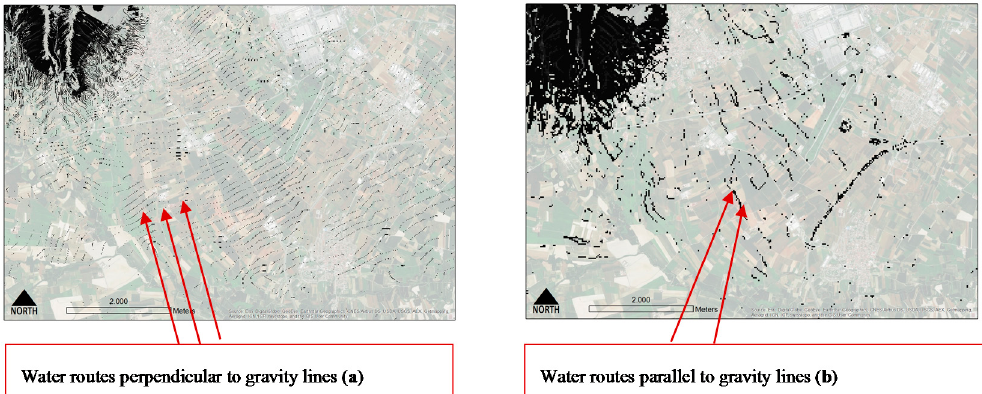
Figure 4. An example of the different distribution of streams after the intermediate process of runoff. ( a ) The streams in the model generate mistakes; and ( b ) the streams in the model correspond to the linear water bodies.